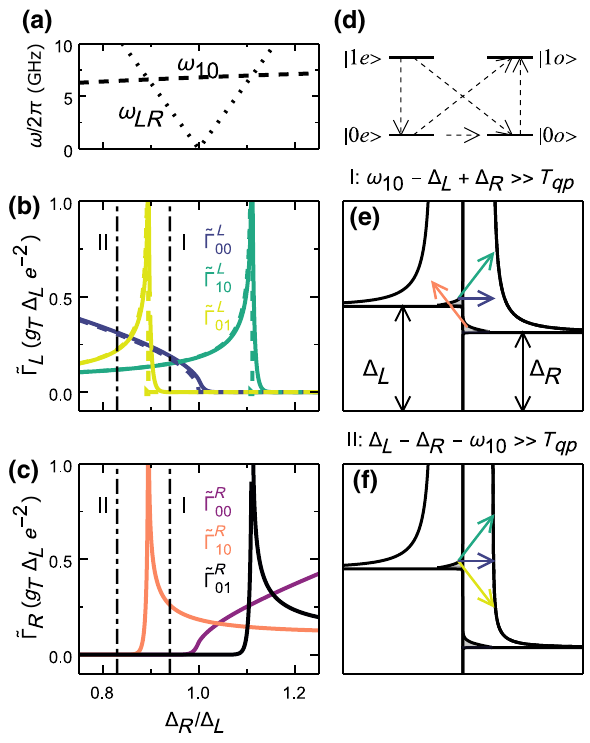
FIG. 2. The gap asymmetry and the qubit transition rates in thermal equilibrium. (a) The qubit frequency and gap-difference frequency as a function of the right electrode gap. (b),(c) Qubit transition rates [obtained from Eq. (4) using the matrix elements in Appendix A] associated with quasiparticle tunneling (b) from the left and (c) from the right electrodes as a function of the right electrode gap. The rates can diverge at (cid:2) L − (cid:2) R = ± ω 10 (see the text). The analytical expressions for the rates [dashed curves in (b)] are given in Appendix B 2. Parameters: (cid:2) L = = 70 E = 20 mK. (d) 260 μ eV, E C / h = 300 MHz, E 0 C , and T J The schematics of the lowest-energy states of the qubit with logical state i = { 0, 1 } , parity j = { e , o } , and the corresponding qubit transitions (arrows). (e),(f) The relevant tunneling events for two choices of gap ratio exemplifying (e) case I and (f) case II, respectively [cf. dotted-dashed vertical lines in (b) and (c)].